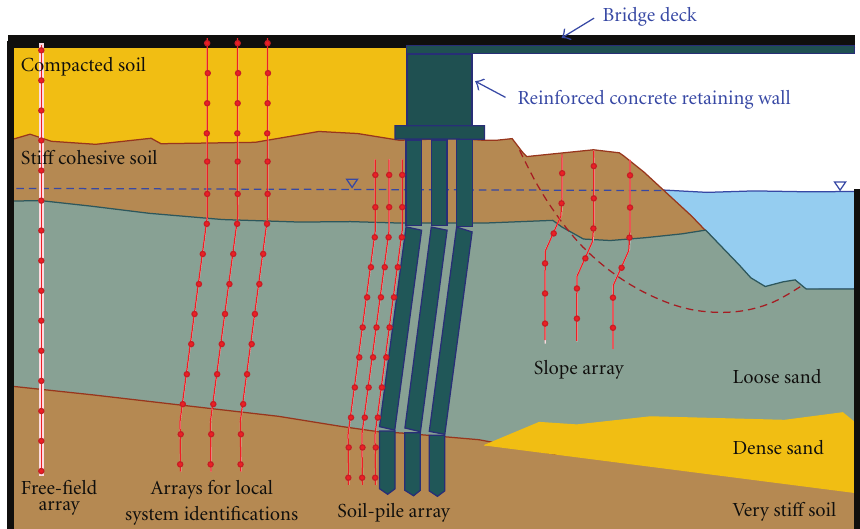
Figure 14: Sketch rendering the vision of dense local instrumentation of active soil and soil-structure systems using shape acceleration arrays (SAAs).